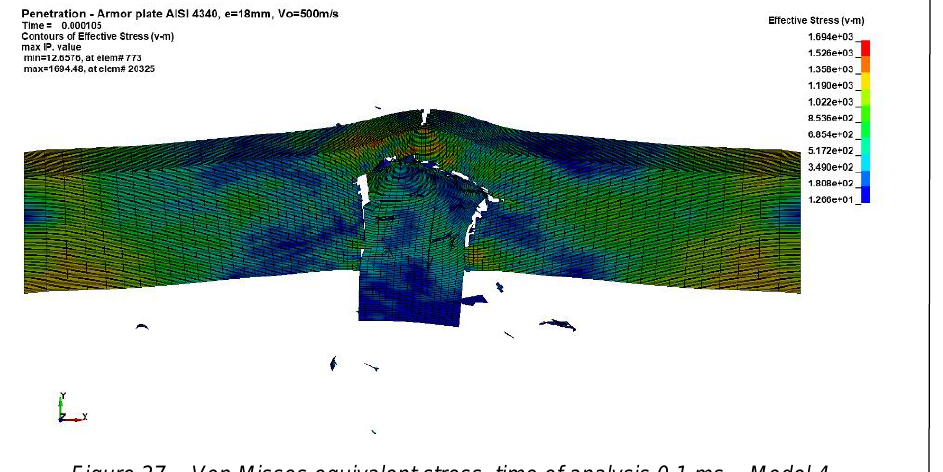
Figure 27 – Von Misses equivalent stress, time of analysis 0.1 ms – Model 4 Рис. 27 – Von Misses эквивалентное напряжение, время анализа 0.1 ms – Модель 4 Слика 27 – Von Misses-ов еквивалентни напон, време анализе 0,1 ms – модел